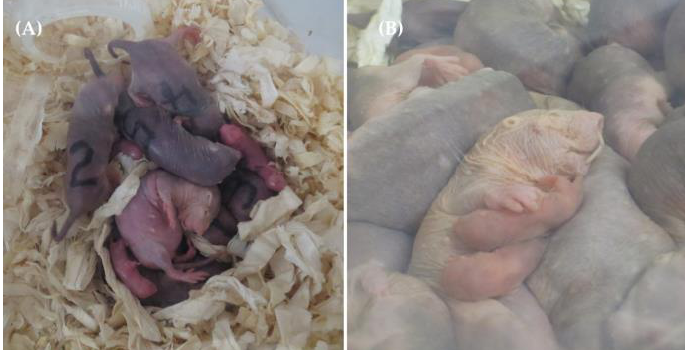
Figure 1. Naked mole-rat colonies huddling together in the nest, with the breeding female lying on the top of the pile. Picture ( A ) shows a small naked mole-rat colony (six non-breeders + queen + her pups) with enough space in the nestbox for the newborn pups to easily crawl around the huddle. Picture ( B ) shows a large colony (60 mole-rats) with the breeding female lactating her pups on the top of the crowded huddle.